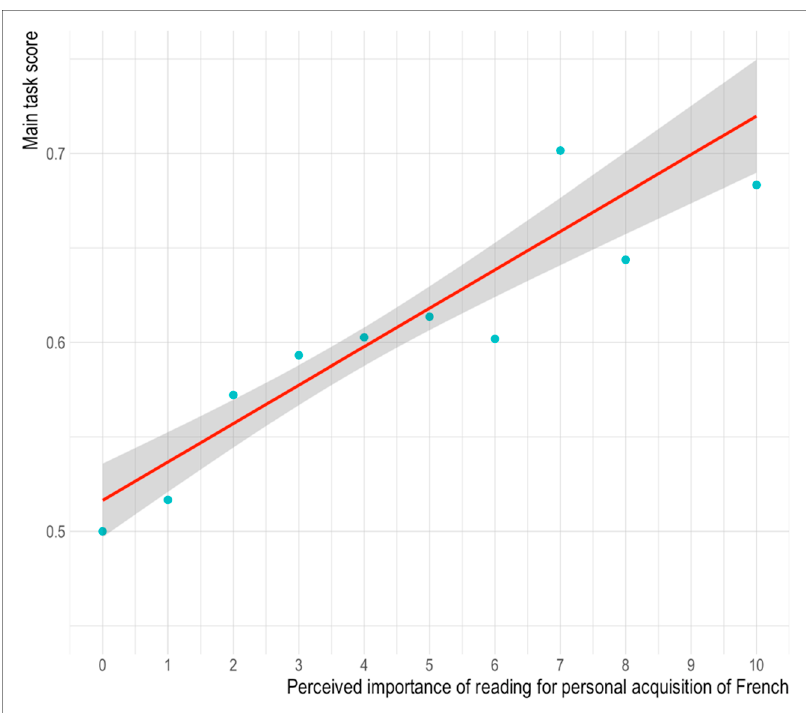
Figure 13. Relation between the scores in the main task and the subjective importance of reading for the personal acquisition of the French language (0–10) by the non-native participants .